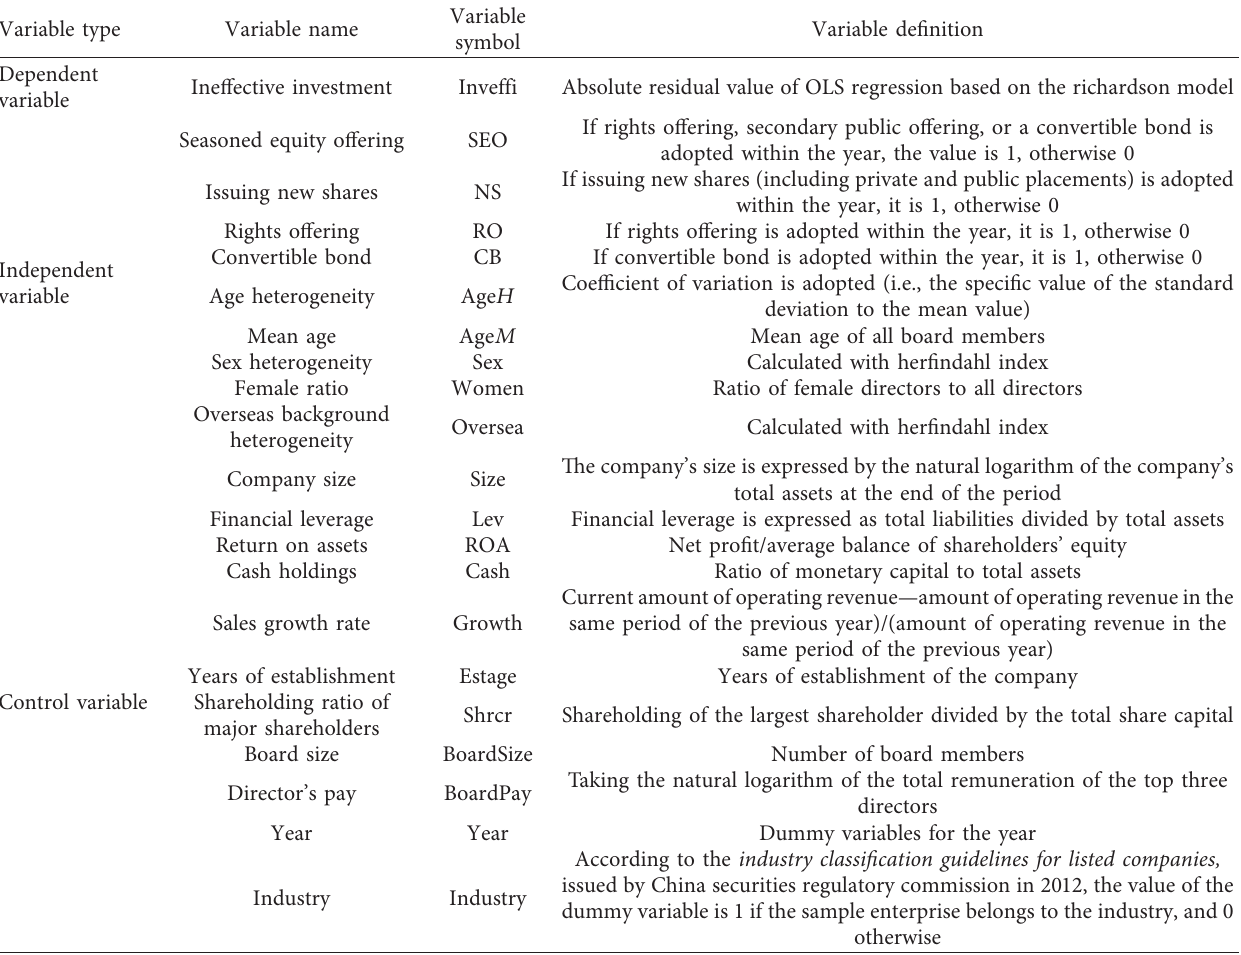
Table 1: Variable